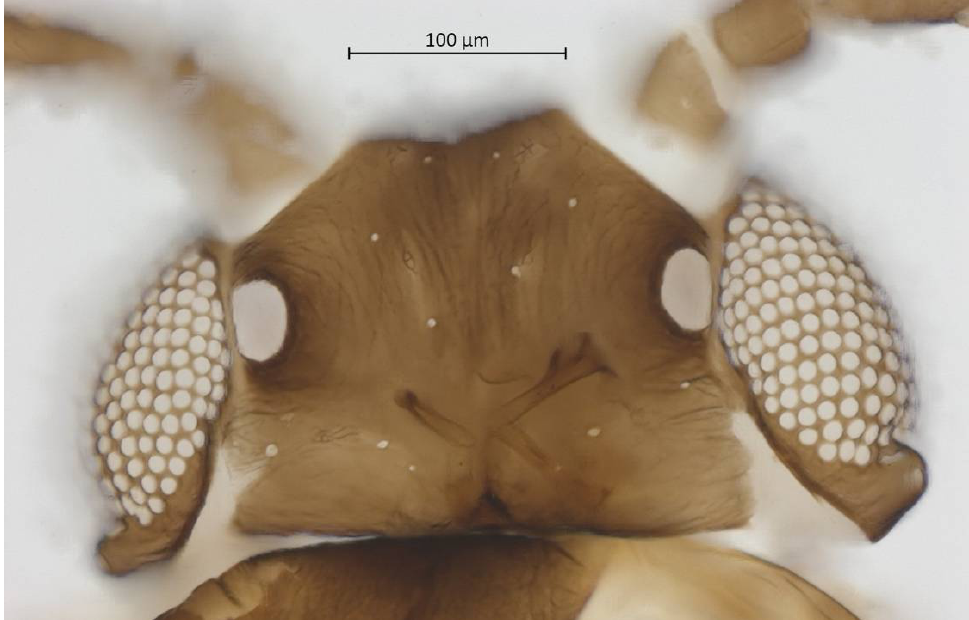
Figure 3. Dorsal head of alate vivipara holotype of Qiao jinshaensis sp. nov. (IOZ(E)54809).